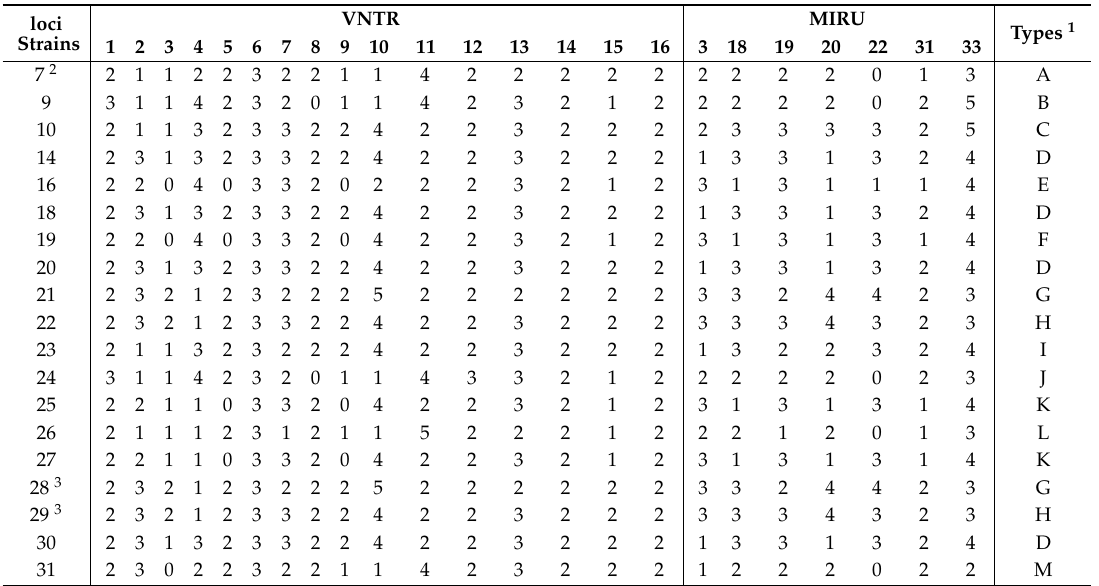
Table 1. Variable number tandem repeat (VNTR) and VNTR-mycobacterial interspersed repetitive units (MIRU) profiles of 19 M. intracellulare representative isolates.